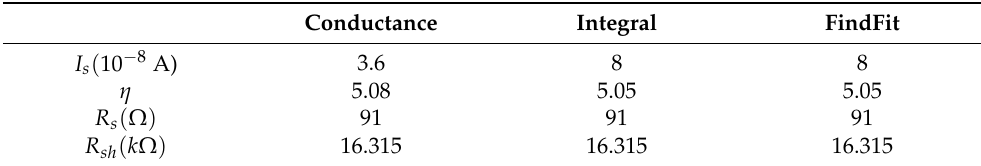
Table 3. Organic Schottky diode physical parameters values obtained via three different methods using the experimental current–voltage data.